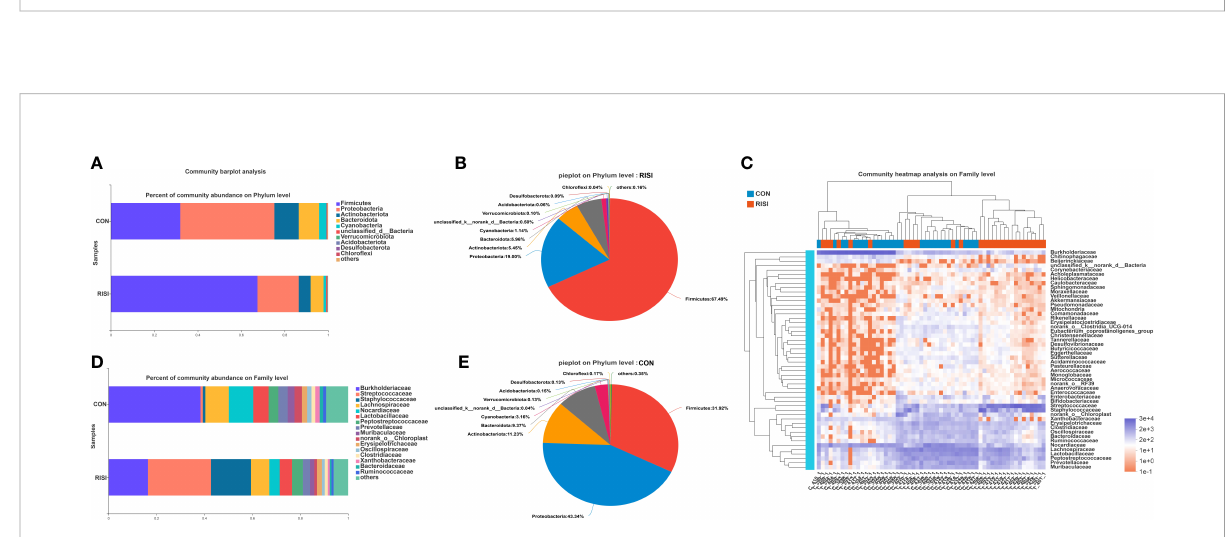
FIGURE 2 Species composition analysis. (A) Phylum-level analysis of the skin microbiota. Bar charts illustrate the relative proportions of dominant phyla across all study groups. (B) Pie chart illustrating the proportions of species at the phylum level in healthy skin. (C) Community heatmap. (D) Family-level analysis of the skin microbiota using bar charts. (E) Pie chart illustrating the proportions of species at the phylum level in radiation-induced skin injury (RISI).